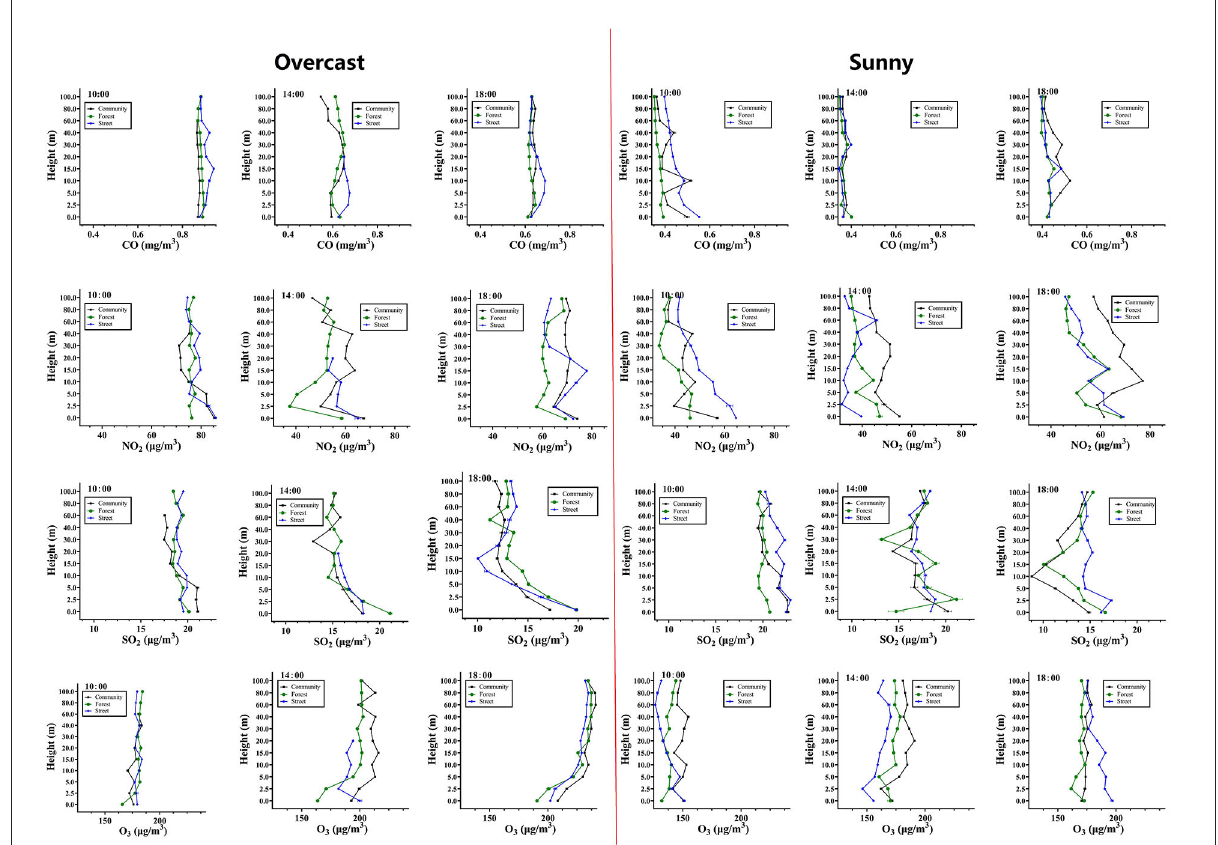
FIGURE3 Hourly vertical distributions of carbon monoxide (CO), sulfur oxide (SO 2 ), nitrogen dioxide (NO 2 ), and ozone (O 3 ) concentrations (mean ± SE) on overcast and sunny days,